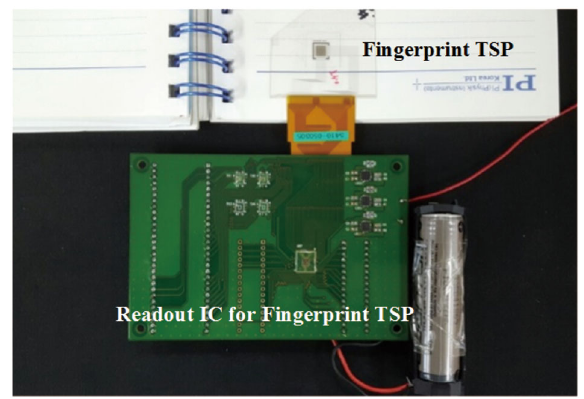
Fig. 16 Fingerprint touch screen panel and associated IC